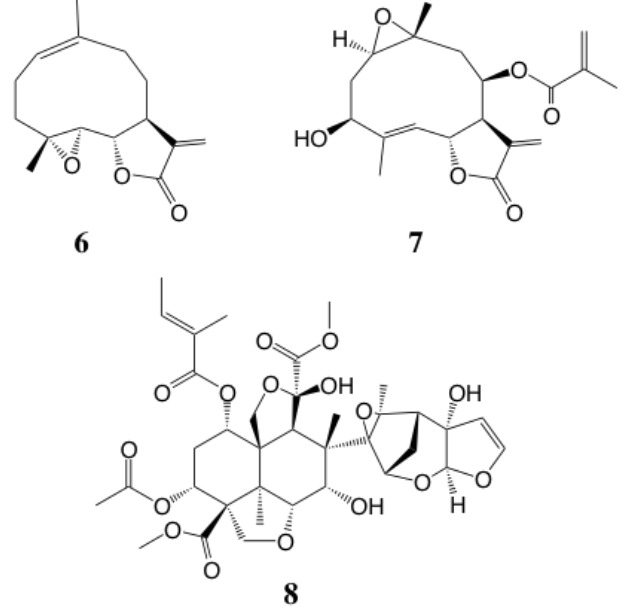
Figure 5. Melampolide analogs 6 , 7 and azadirachtin A ( 8 ) used for the evaluation of insect antifeedant activity.